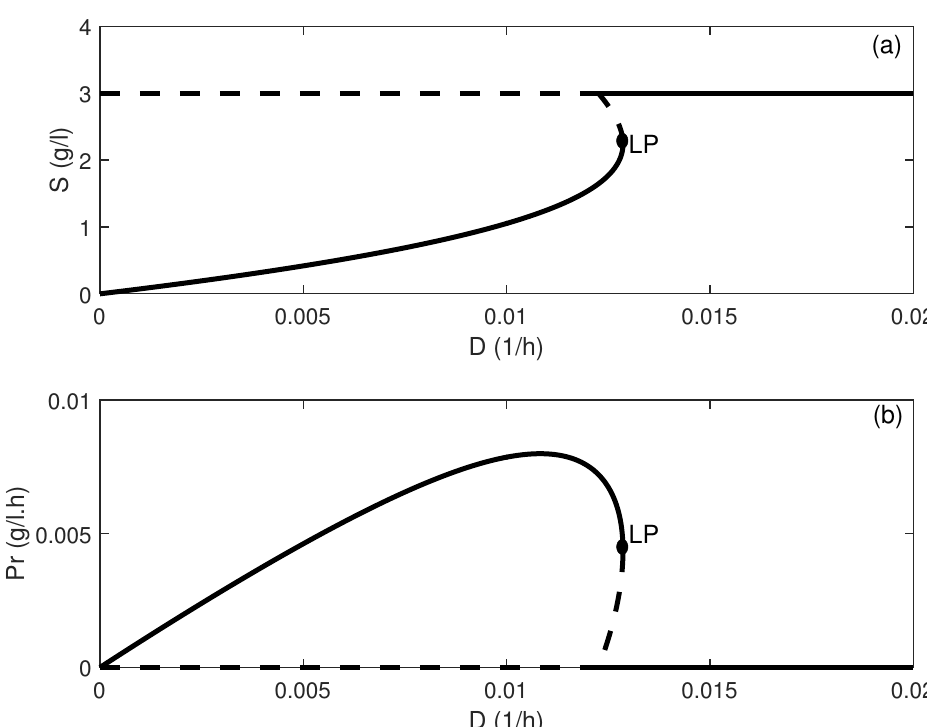
Figure 1. Model behavior for nominal parameters of Table 1: ( a ) continuity diagram, ( b ) productivity. Solid line (-) stable branch. Dashed line (- -) unstable branch. LP, static limit